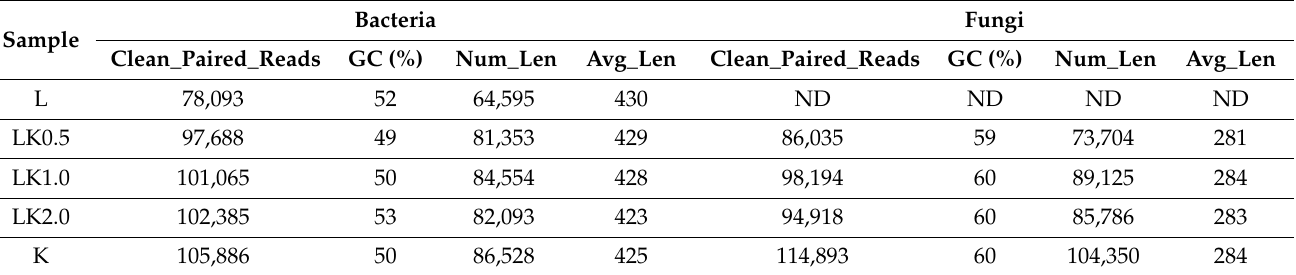
Table 1. Sample sequencing results.